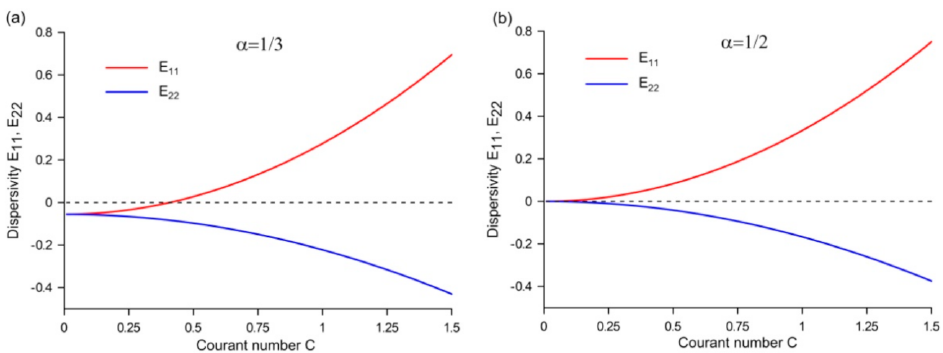
Figure 5. The values of the dispersivity tensor components E 11 and E 22 versus the Courant number C calculated using the 6NI mesh structure for: ( a ) α = 1/3; ( b ) α = 1/2.